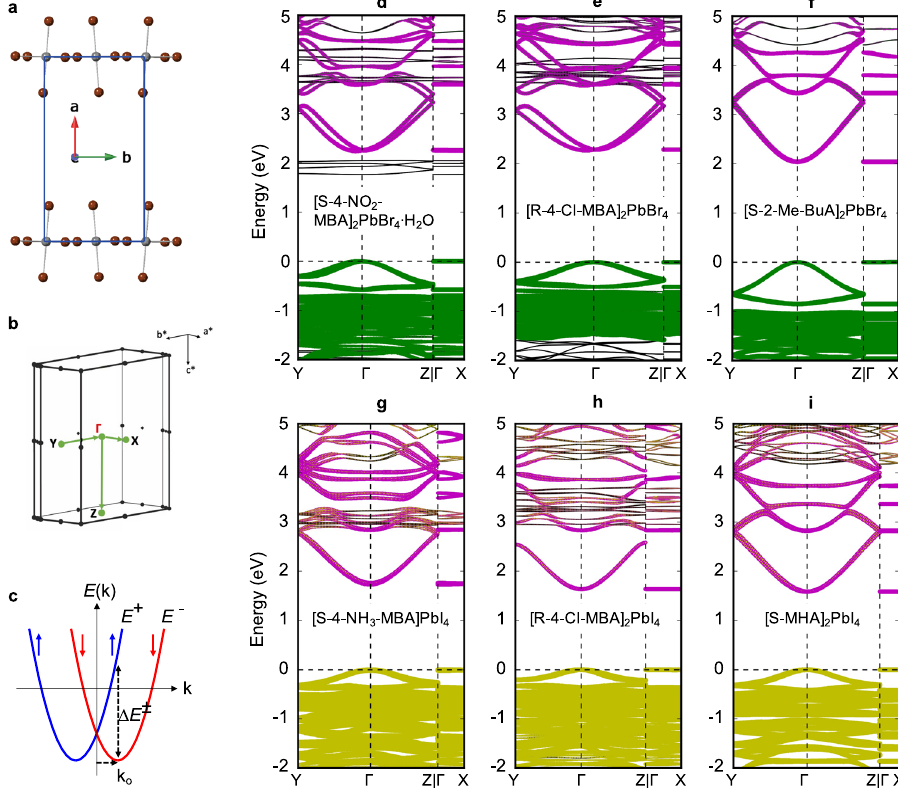
Fig. 3 Spin-splitting in chiral MHPs. a A representative unit cell of a relaxed MHP (organic cations are omitted) and ( b ) the corresponding Brillouin zone in the reciprocal space used for band structure calculations. c Schematic representation of spin-polarized subbands separated in k-space along one dimension of a Rashba or Dresselhaus semiconductor. The ↑ and ↓ arrows denote, respectively, + 1/2 and − 1/2 like spin character. E (cid:3) and E þ denote the two spin subbands, and Δ E ± denotes the energy difference between them at a characteristic momentum offset, k 0 . d – i DFT-PBE + SOC band structures of chiral [S- 4-NO 2 -MBA] 2 PbBr 4 ⋅ H 2 O ( d ), [R-4-Cl-MBA] 2 PbBr 4 ( e ), [S-2-Me-BuA] 2 PbBr 4 ( f ), [S-4-NH 3 -MBA]PbI 4 ( g ), [R-4-Cl-MBA] 2 PbI 4 ( h ), and [S-MHA] 2 PbI 4 ( i ) along select k-paths. Relaxed atomic geometries were used for band structure calculations. Pb-, Br-, I- and organic-derived electronic states are highlighted in purple, green, yellow, and black colors, respectively. Note that the focus of these plots is the degree of SOC near the inorganic-derived conduction band edges, not the alignment of energy levels or the exact fundamental